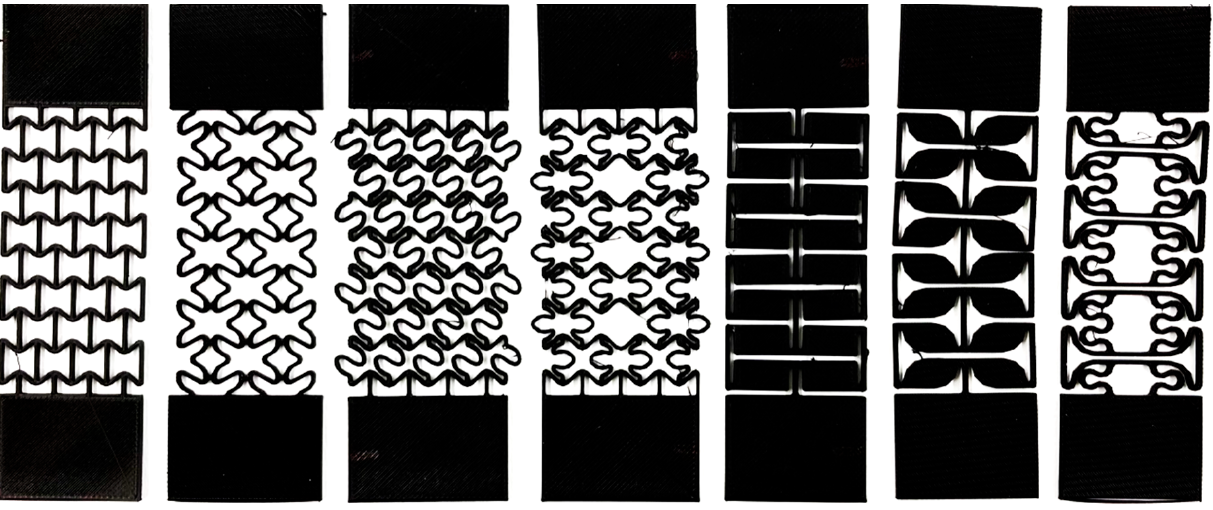
Figure 1. The printed samples, left to right: CRE, RCSS, SS, HISS, KHS, KD, and KH. The dimension of each structure was designed as 60 mm × 30 mm × 1.5 mm, respec- tively, in length, width, and height. The connecting link width was set at 0.975 mm